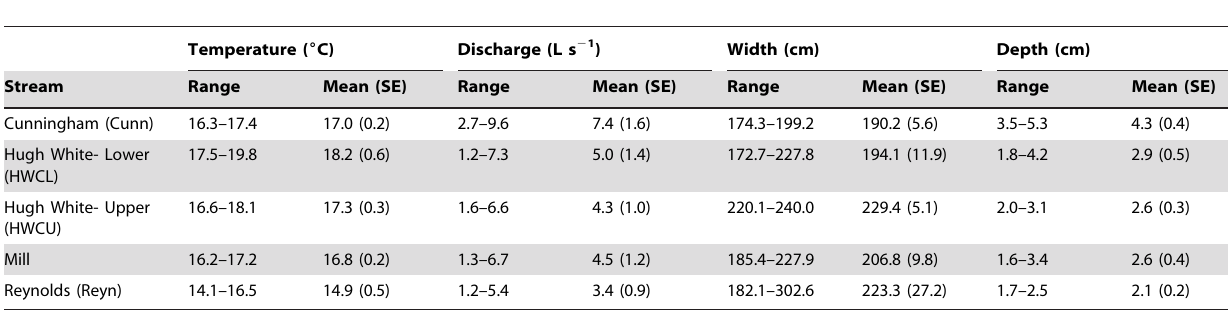
Table 1. Stream characteristics. Physical measures of the 5 study streams in Coweeta during July 2008–2011.